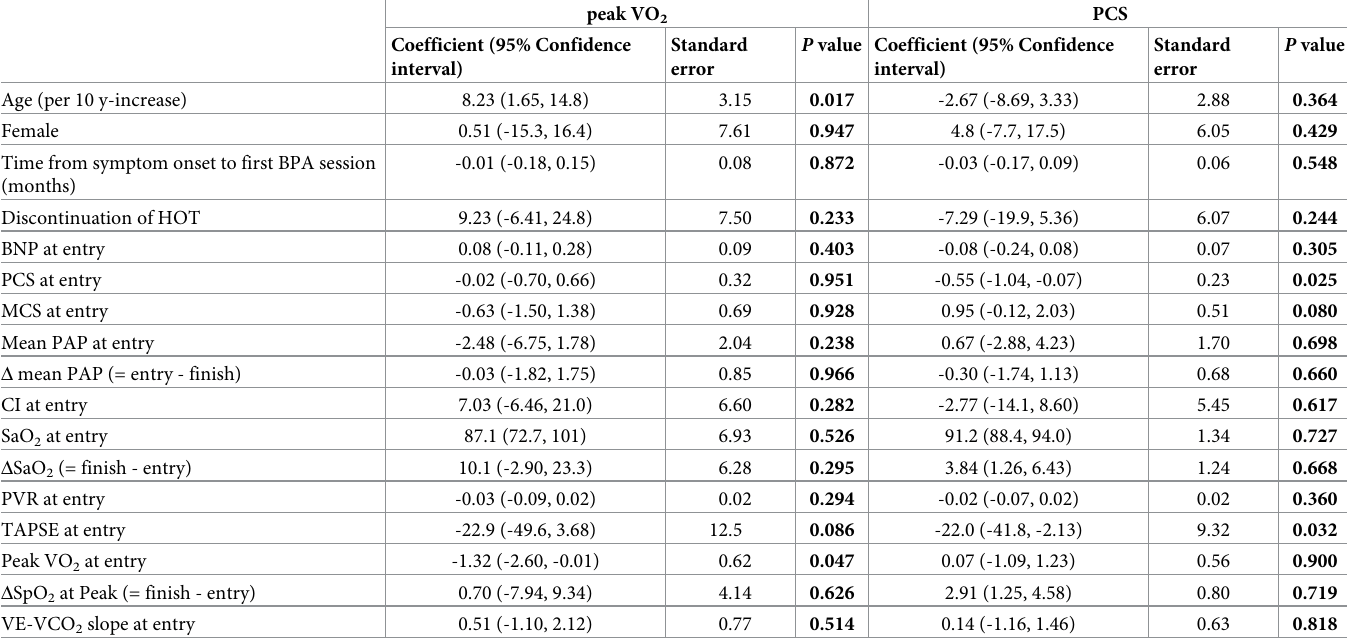
Table 6. Predictors associated with improvement of peak VO 2 and